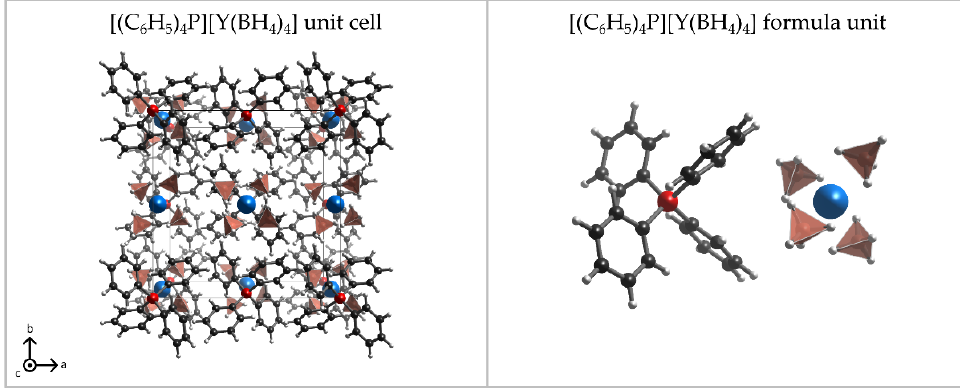
Figure 3. Visualisation of the unit cell ( left ) and the asymmetric unit ( right ) of the crystal structure of [Ph 4 P][Y(BH 4 ) 4 ]. Atom code — C: black, B: orange, H: white, P: red, Y: blue.